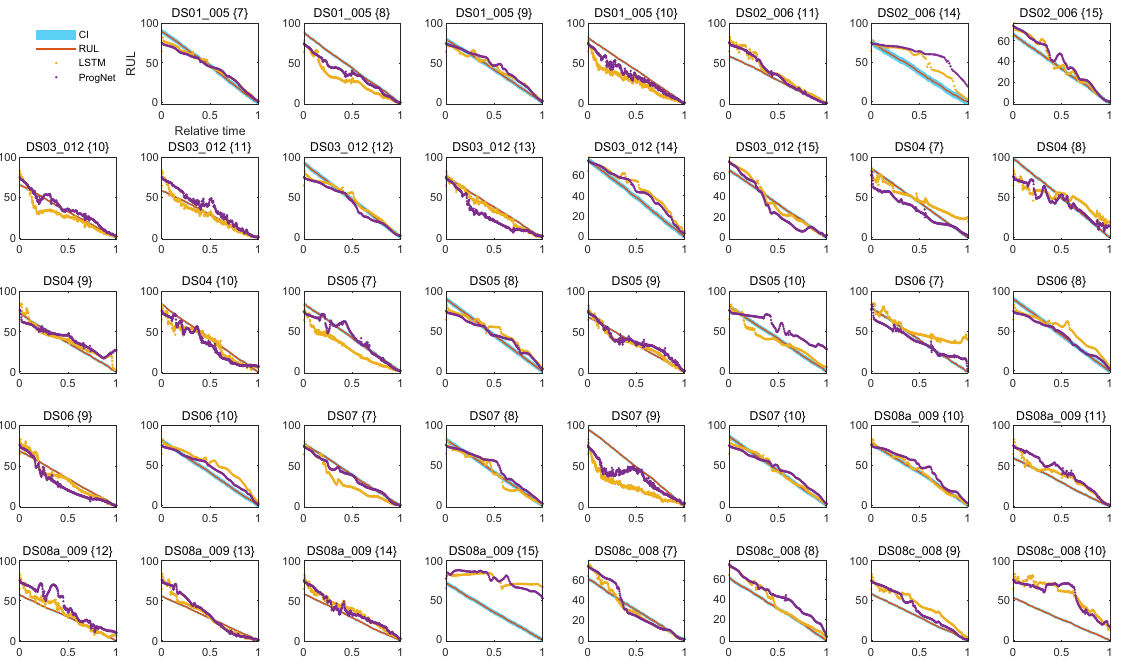
10 of 13 Table 4. Obtained evaluation results. Algorithm